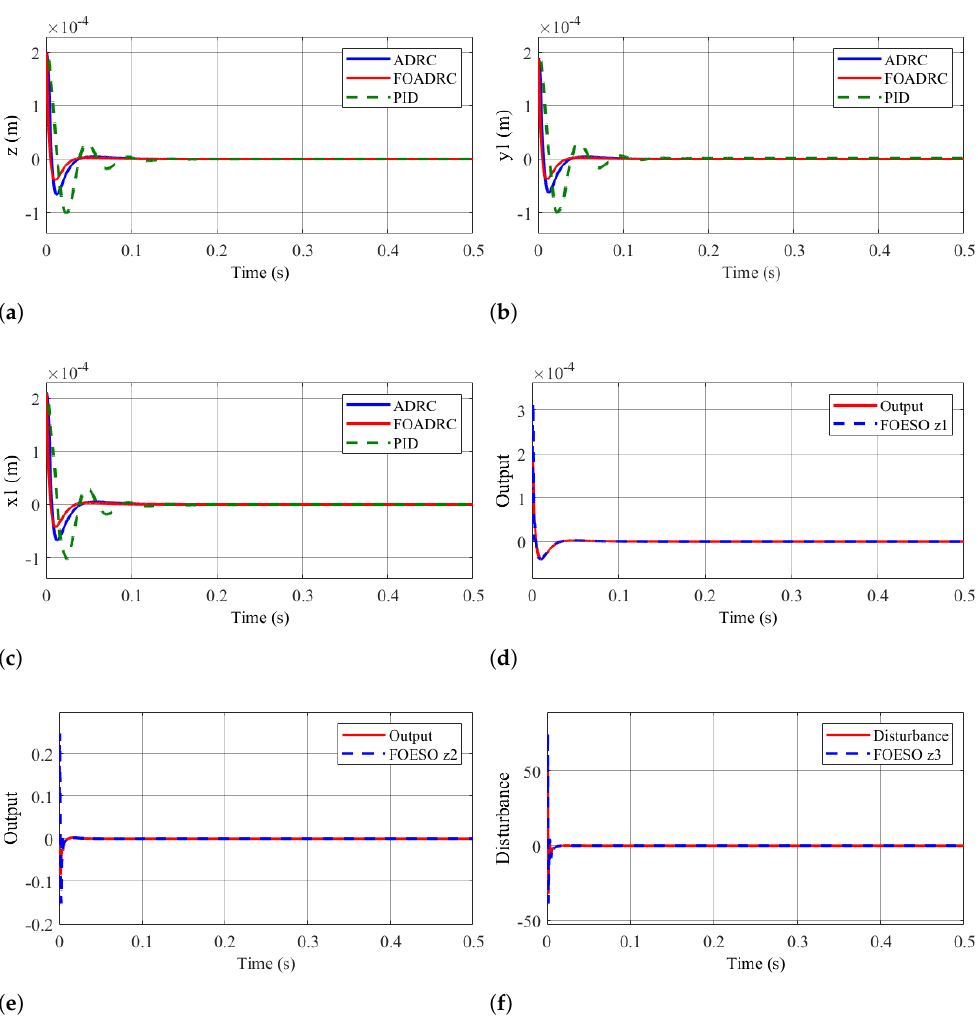
Figure 7. Transient response when the rotor lifts up with FOADRC, ADRC, and PID controller ( a – c ). ESO estimation with the FOADRC method on the plant model is presented in ( d – f